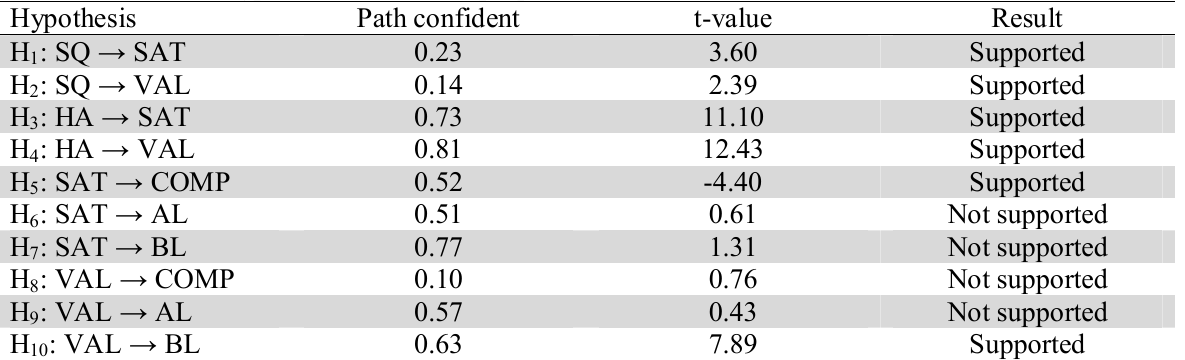
Path estimates and hypotheses results for proposed